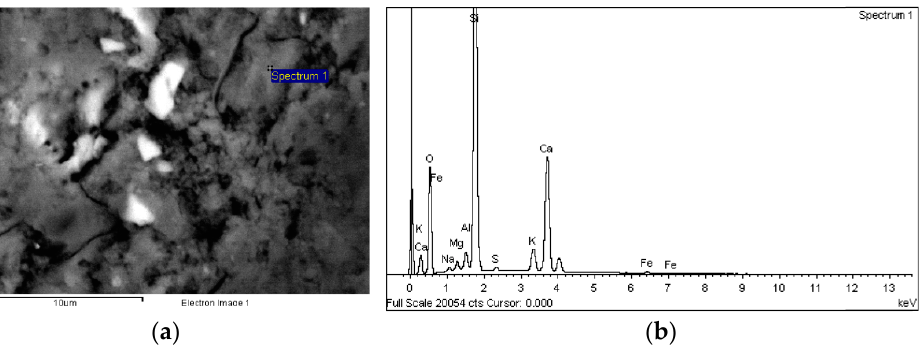
Figure 6. ( a ) BSE micrograph of UH-2F-60 (5000×) and ( b ) EDX spectrogram and chemical composition of the area identified on the micrograph.